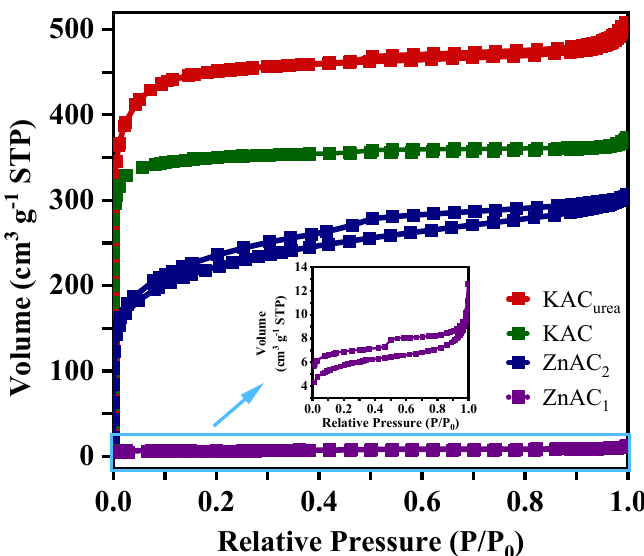
Figure 5. Comparison of N 2 adsorption–desorption isotherms of KAC urea , KAC, ZnAC 1 , and ZnAC 2 . The inset shows the hysteresis loop for ZnAC 1 .